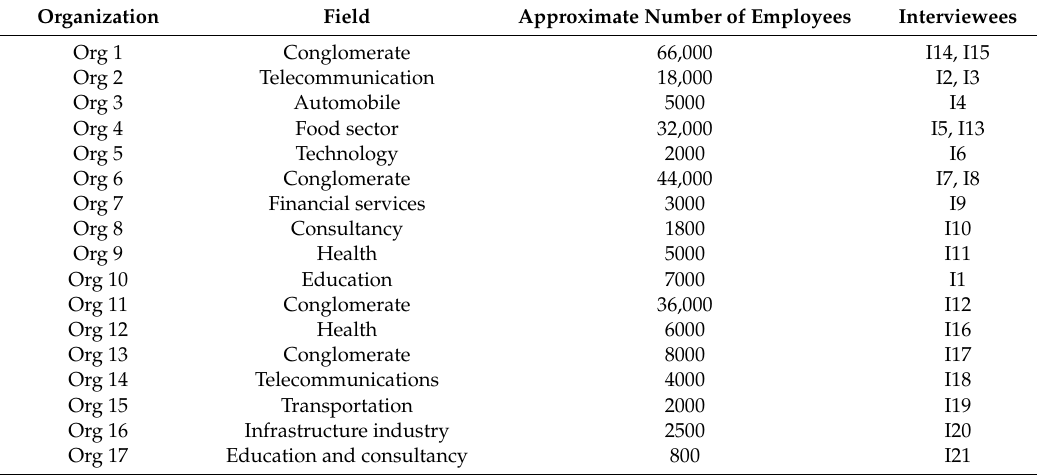
Table 2. Organizational